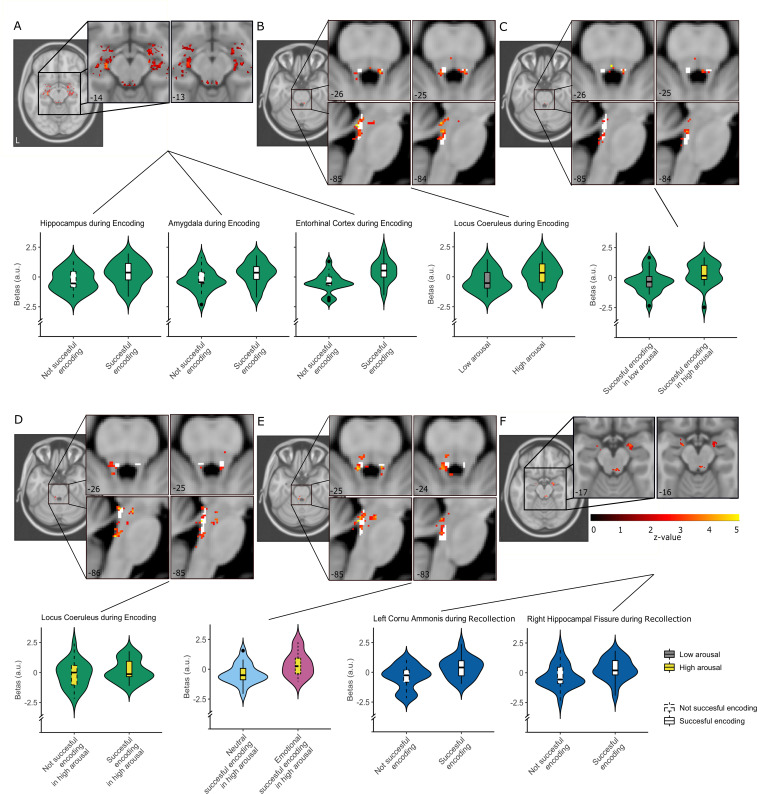
LC and MTL activity during the task stages (N = 24).(A) Bilateral hippocampus, bilateral amygdala and entorhinal cortex activation during encoding (Encoding >Not Encoding; thresholded at p<0.05, uncorrected). (B–E) LC activation during encoding (z-values thresholded at p<0.05, uncorrected). (B) LC activation during successfully encoded events with high arousal (HRV minima) (High Arousal successful encoding >Low Arousal successful encoding). (C) LC activation during High Arousal Encoding >Low Arousal Encoding and during D) High Arousal successful Encoding >High Arousal forgotten. (E) Activation of LC for emotionally high arousal encoding events (High Arousal Emotional Encoding >High Arousal Neutral Encoding). (F) Bilateral CA1 activation during recollection of correctly encoded trials (Successful recollection >Forgotten recollection) (z-values thresholded at p<0.05, uncorrected). Boxplots inside the violinplots show median, quartiles (boxes) and range (whiskers). The layer containing white voxels demonstrates the location of the Keren template as reference (Keren et al., 2009). Individual brainstem results for the encoding contrasts are shown in Figure 6—figure supplement 2.Figure 6—source data 1.Locus coeruleus and medial temporal lobe activity during the task stages.Individual beta’s are provided for the amygdala, hippocampus and locus coeruleus for the examined relevant contrasts during encoding.